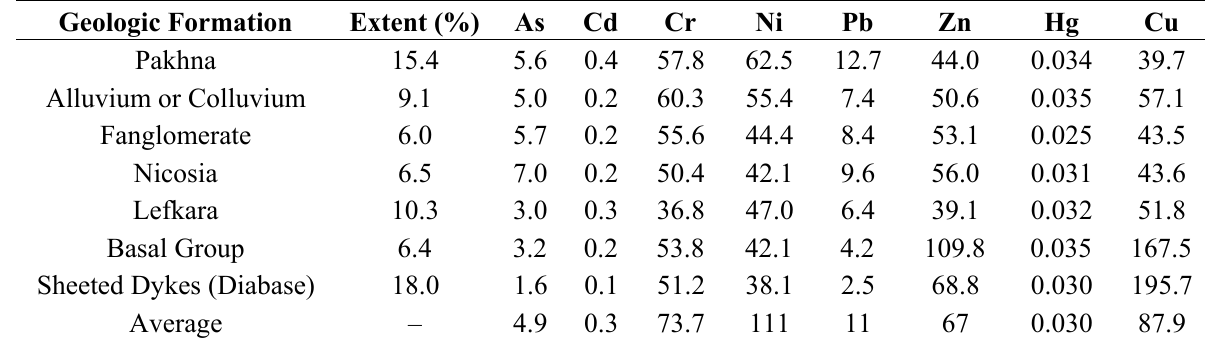
Table 1. Heavy metal surface mean concentrations in various geologic units of Cyprus (in mg·kg − 1